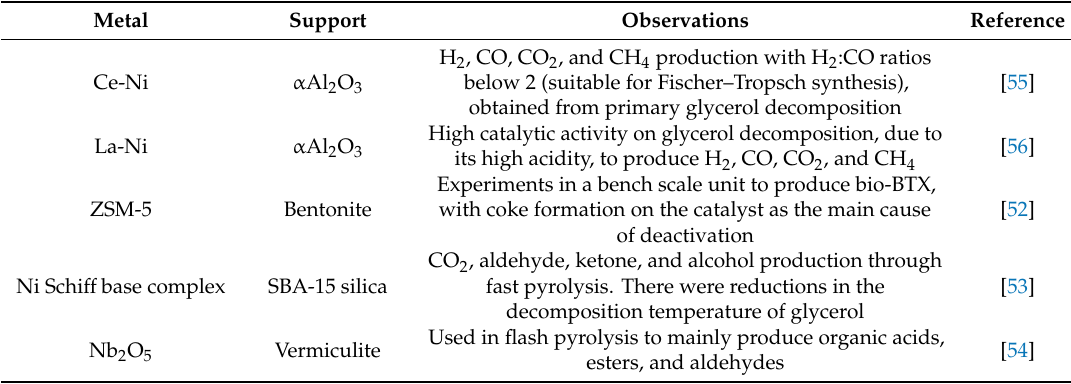
Table 1. Catalysts recently used in glycerol